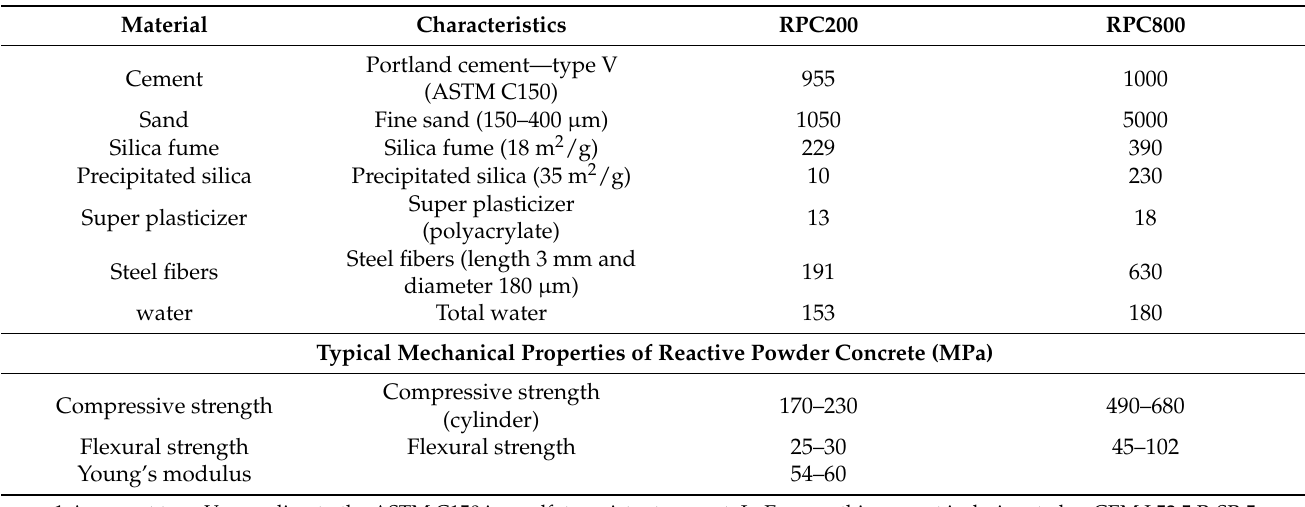
Table 2. Typical composition, kg/m 3 , and main mechanical properties, MPa, of reactive powder concretes RPC200 and RPC 800.